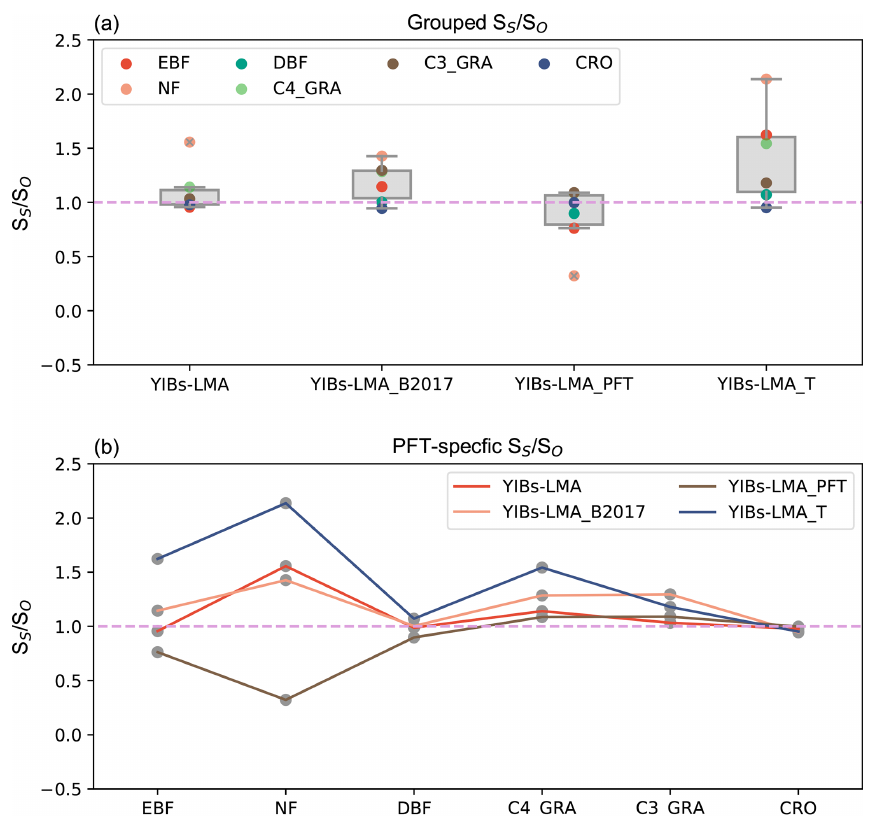
Figure 7. Comparison of S S /S O among supporting experiments. Individual ratios for (b) different PFTs are grouped to the box plot in (a) . All experiments adopt optimal parameters shown in Table